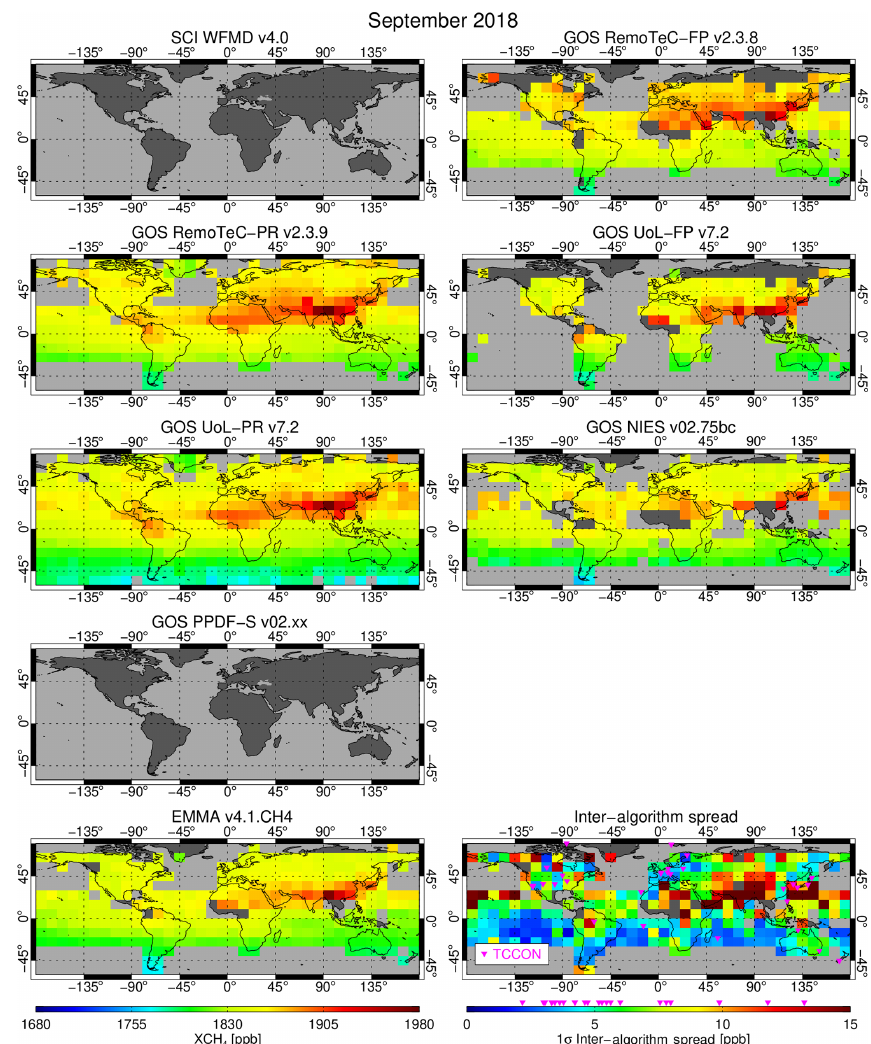
Figure 15. As Fig. 14 but for September 2018. Note that the SCIAMACHY/WFMD map (top left) is empty because this product ended in April 2012 (see Fig. 14 for SCIAMACHY/WFMD XCH 4 ). For product GOSAT/PPDF (row 4) no data were available for this month (see Fig. 14 for GOSAT/PPDF XCH 4